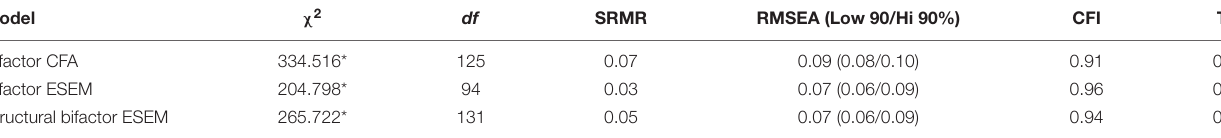
TABLE 3 | Bifactor CFA, bifactor ESEM, and structural bifactor ESEM model fit indices for the SDT-L2.